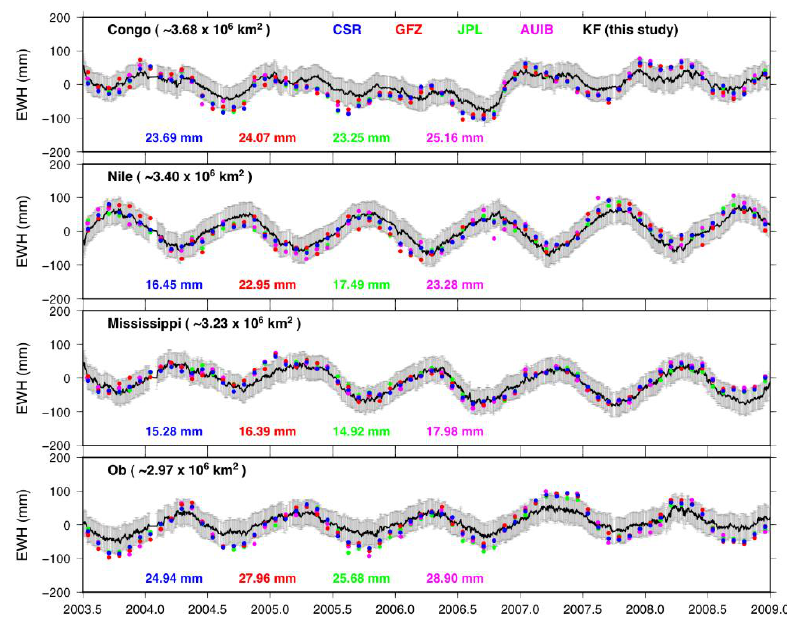
Figure 4. Time series of daily KF GRACE solutions (black) averaged over the largest drainage basins of the world. Error bars represent uncertainty on the spatial averages of daily KF solutions. Monthly estimates from the official centers CSR, GFZ, JPL, and AIUB are plotted in colors for comparison. RMS differences between one-month averaged KF values and the latter solutions are also indicated. Monthly averages of KF solutions were also compared to the mascons solutions (see Section 3.1—RL05 CSR [20]) for the same monthly period and over South America. They show similar